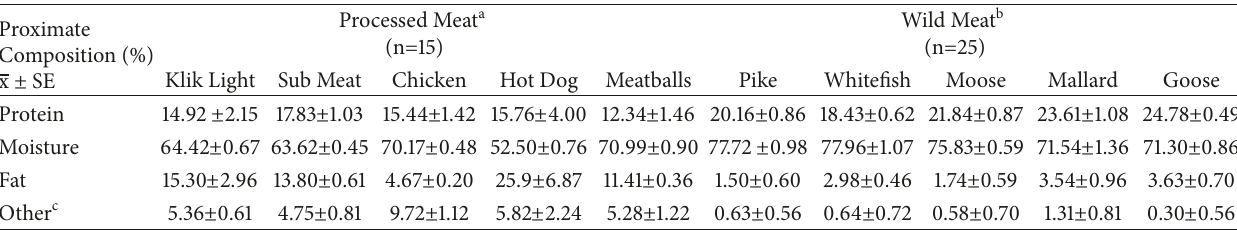
Table 3: Proximate Composition of Processed and Wild Meats.